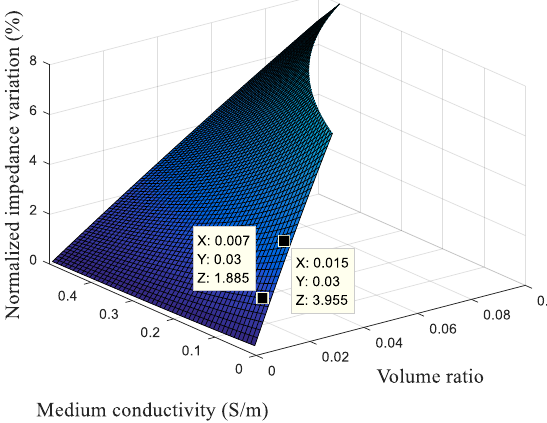
Figure 4. Normalized impedance variation as a function of the volume ratio (ratio of the cell volume/measurement volume —Φ) and medium conductivity for the generic parameter values.